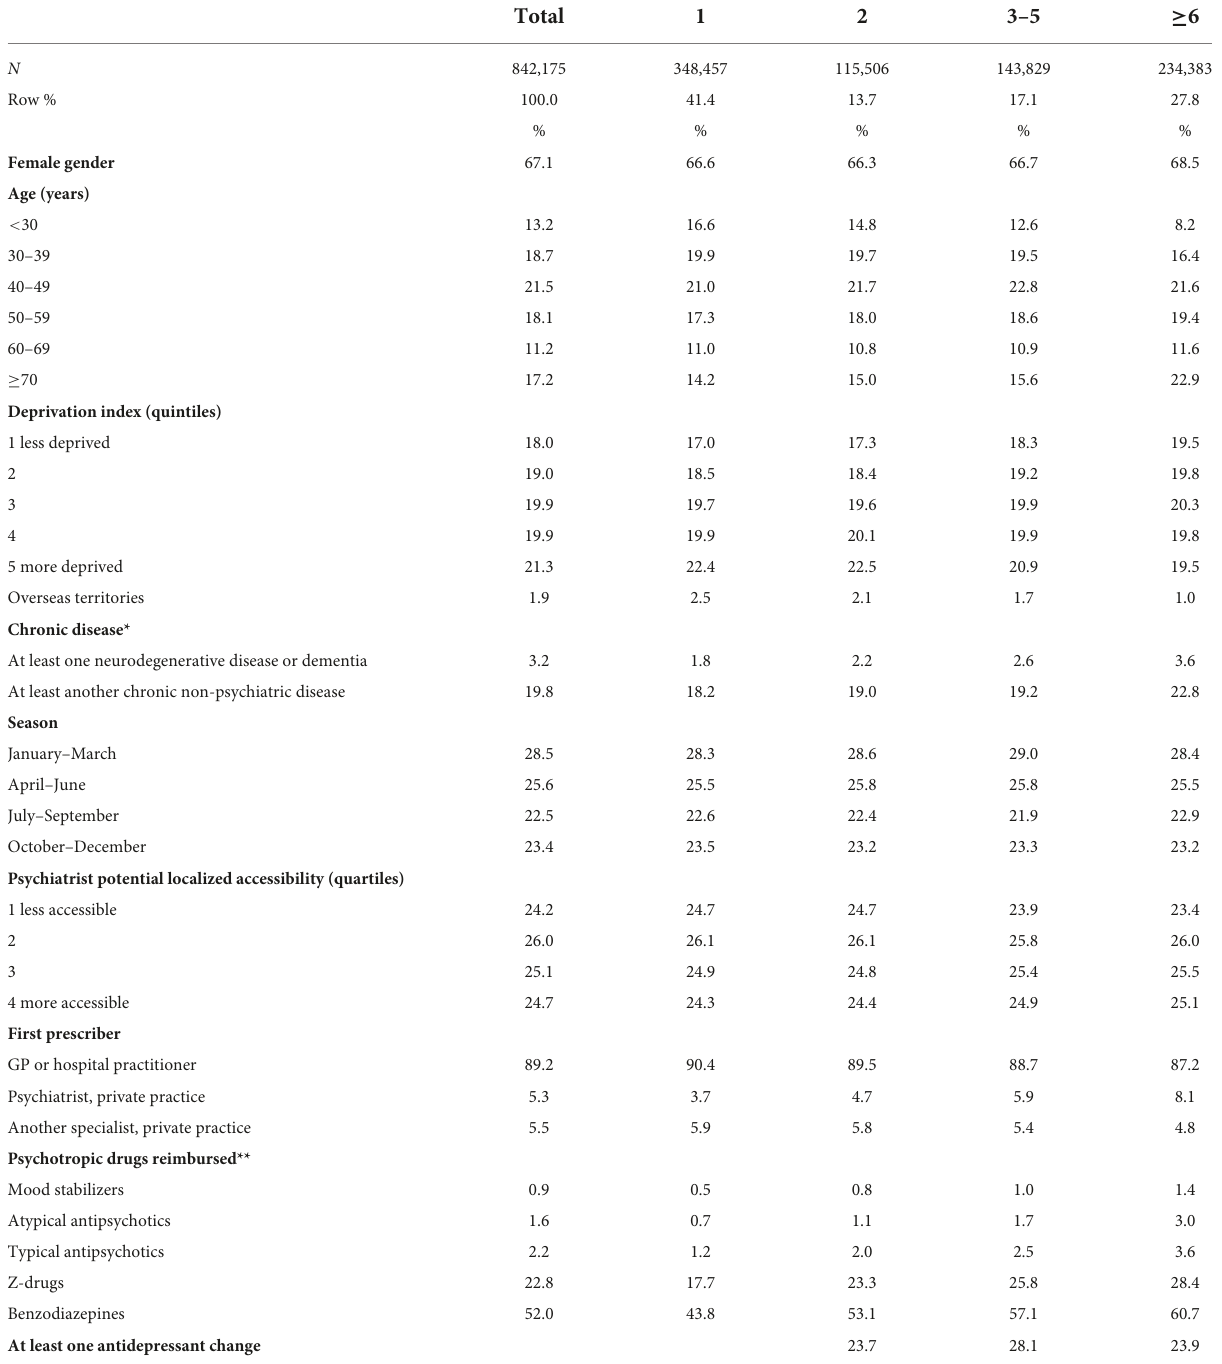
TABLE 1 Characteristics of the population according to the number of filled antidepressant